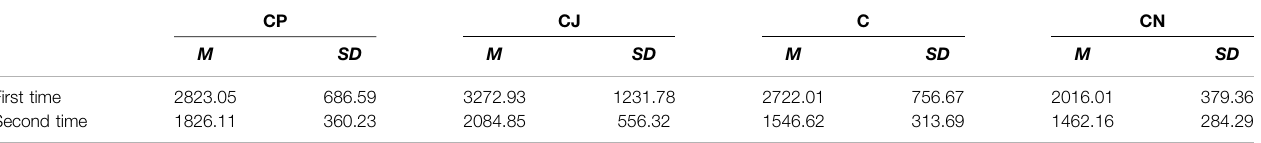
TABLE 11 | Mean response times (ms) and standard deviations ( SD ) in learning condition retrieval tasks. CP CJ